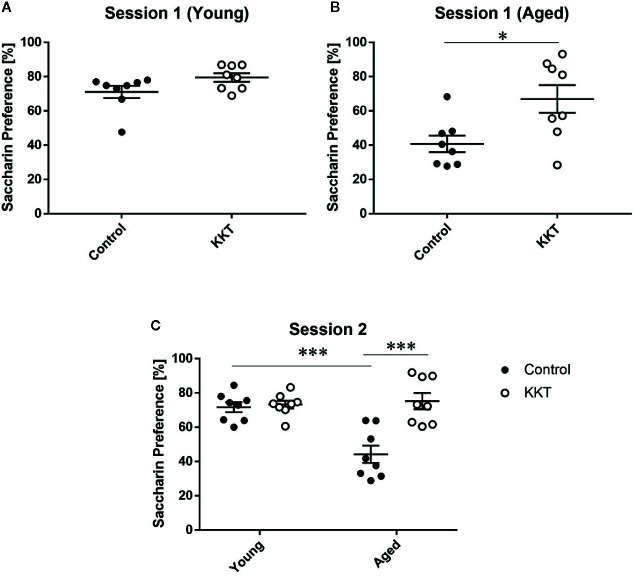
Effects of KKT on sweet preference. (A, B) The percentage of saccharin preference of young (A) and aged (B) mice in session 1. Note that 1% KKT suspension was used as the solvent for saccharin in the KKT groups. Statistical significance was analyzed using unpaired t-tests (*: P < 0.05). (C) The percentage of saccharin preference was calculated for session 2 in which tap water was used as the solvent for saccharin for both control and KKT groups. Statistical analysis was performed by two-way ANOVA followed by Bonferroni multiple comparison (***: P < 0.001). Scatterplot data are presented as mean ± SEM (n = 8).